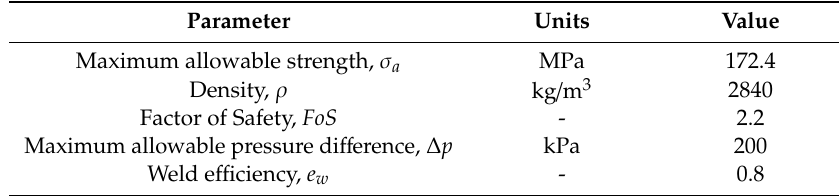
Table 2. Al 2219 tank wall design properties.